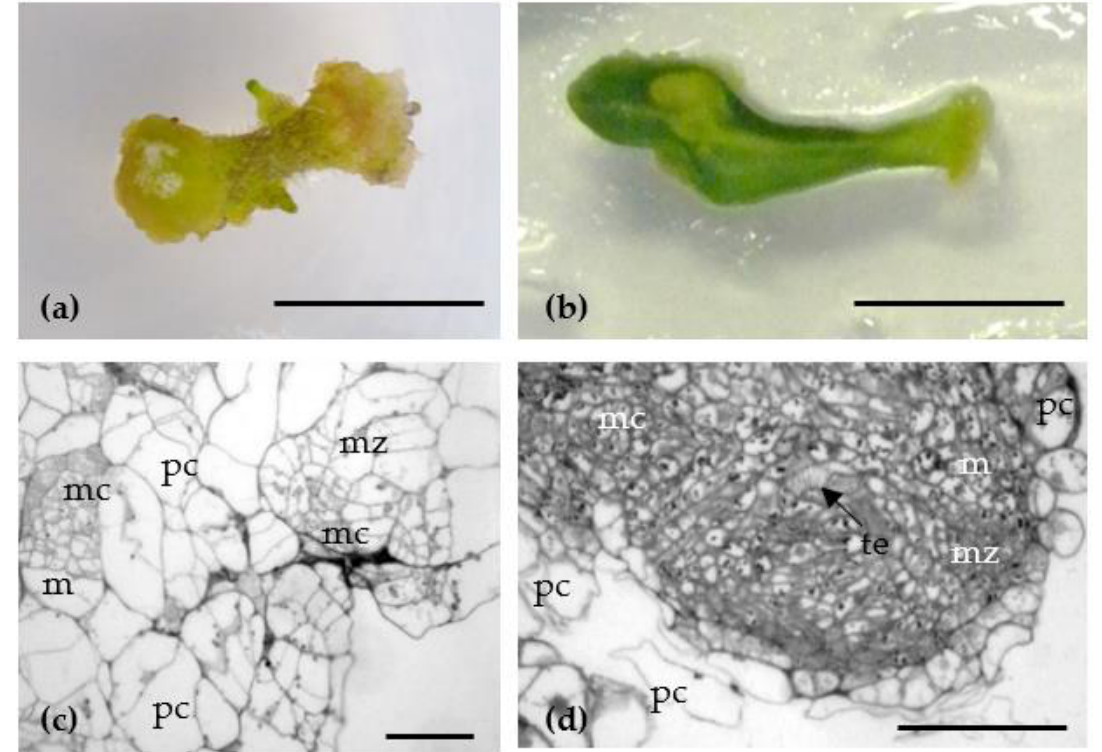
Figure 1. Callus formation from hypocotyl ( a ) and cotyledon ( b ) explants on MS1 culture media supplemented with 5 mg L − 1 6-benzylaminopurine (6-BA) and 0.1 mg L − 1 indole-3-acetic acid (IAA) and its histological analysis ( c , d ). Abbreviations: mz—meristematic zone; mc—meristematic cell; pc—parenchyma cell; te—tracheal element. Bars—1 cm ( a , b ) and 50 μm ( c , d ).